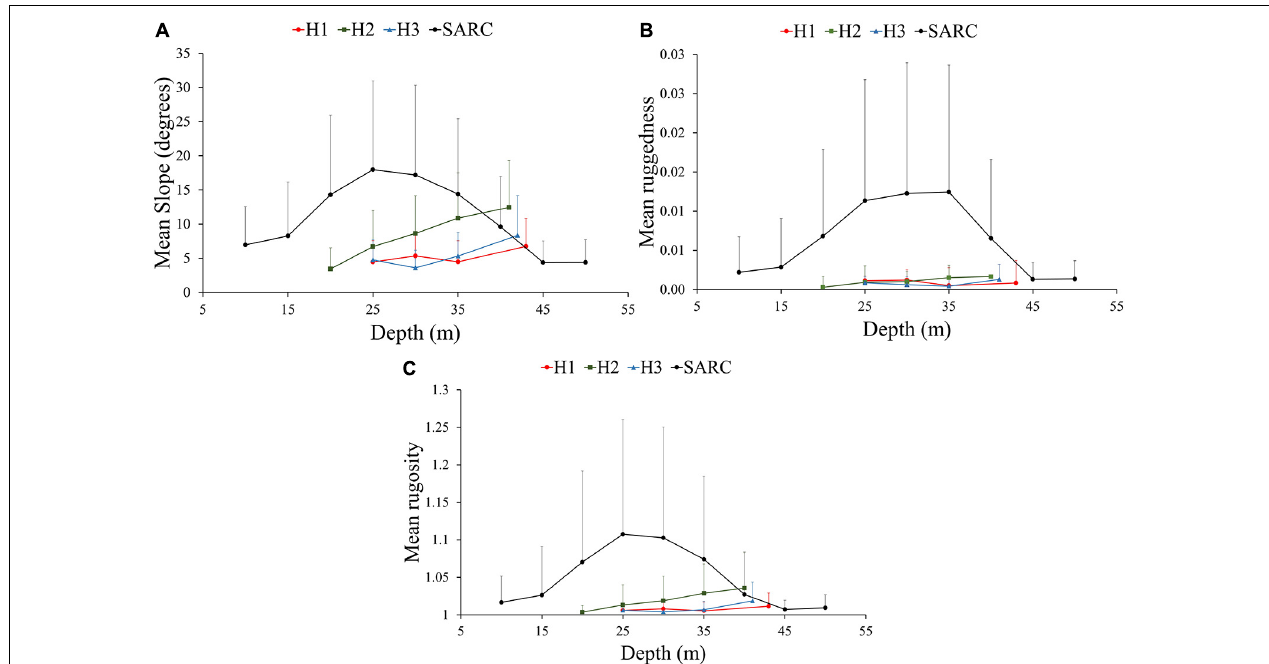
FIGURE 6 | The estimated (A) mean slope, (B) mean ruggedness and (C) mean rugosity, for 5 m depth intervals with standard deviation bars (SD ± 1) for Holandesa group and the